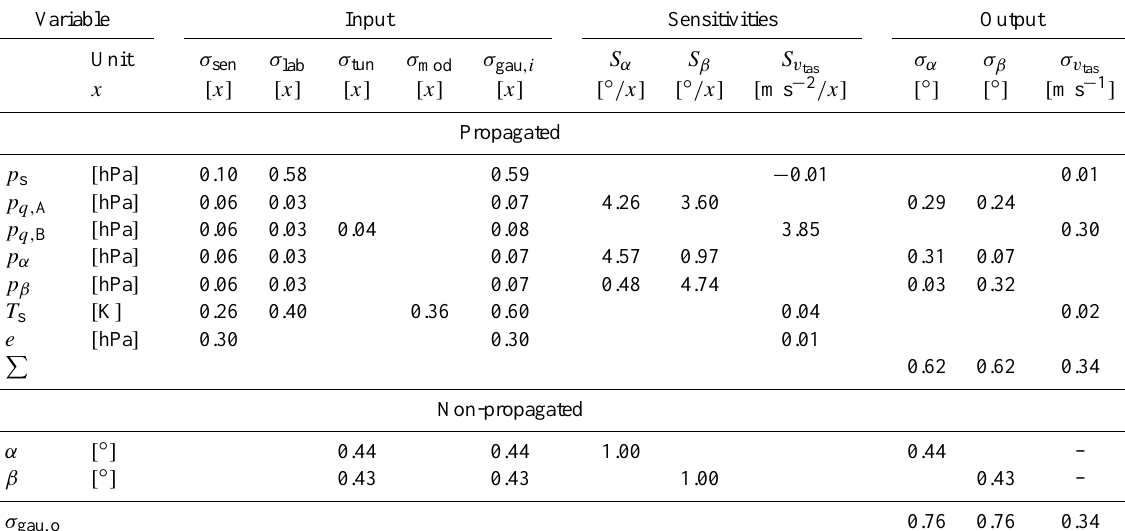
Table 5. Uncertainty of variables entering the wind vector computation Eq. (A1): Static pressure ( p s ), dynamic pressure as used in the computation of flow angles ( p q, A ) and the true airspeed ( p q, B ), differential pressures ( p α , p β ), static temperature ( T s ) and water vapour pressure ( e ). Sources of uncertainty ( σ ) are subscripted as follows: manufacturer provided sensor uncertainty (sen), calibration in laboratory (lab), wind tunnel (tun), and wind model description (mod). The 0.05K and 0.36K uncertainties for radiation and ram rise errors in static temperature ( T s ) were accounted in σ mod . Additional information is given in Sect.